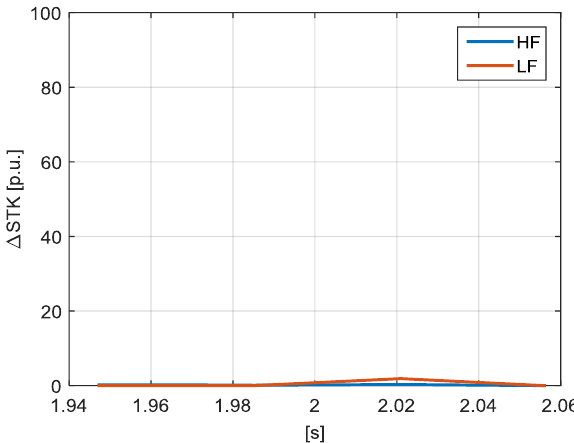
Figure 41. Case study 3: Δ STFD at low-frequency (0 ÷ 2.4 kHz, red line) and at high-frequency (2.4 ÷ 150 kHz, blue line) obtained through Prony’s method.